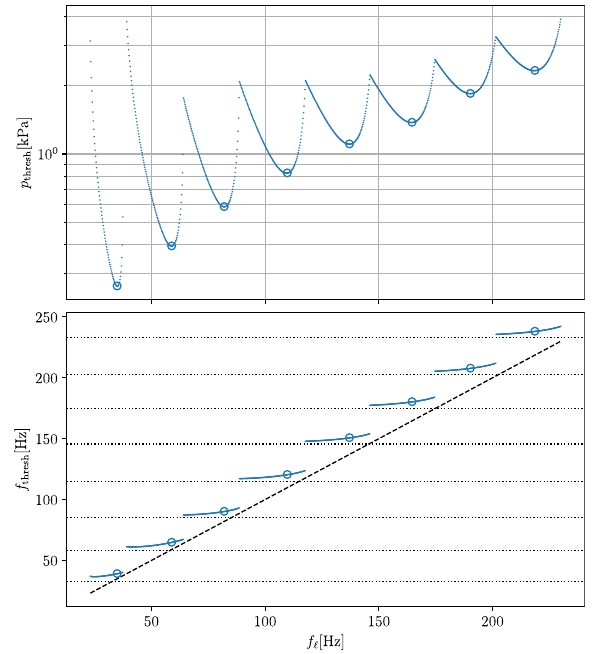
Figure 4. Results of the linear stability analysis applied to the B [ -contrabass tuba. Top and bottom plots represent respectively the threshold mouth pressure and the threshold frequency with respect to the lips ’ resonance frequency. Circles point out the minima of each U-shaped pattern on the top plot. Horizontal dotted lines on the bottom plots locate the values of the acoustical resonances of the resonator; the black dashed line on the bottom plots represents f thresh = f ‘